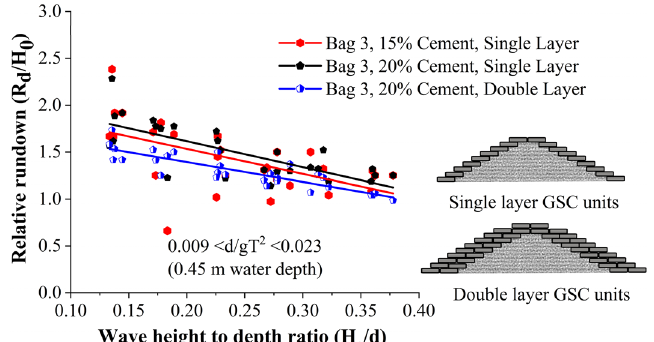
Figure 7. Relative rundown vs wave height to depth ratio (H 0 /d).